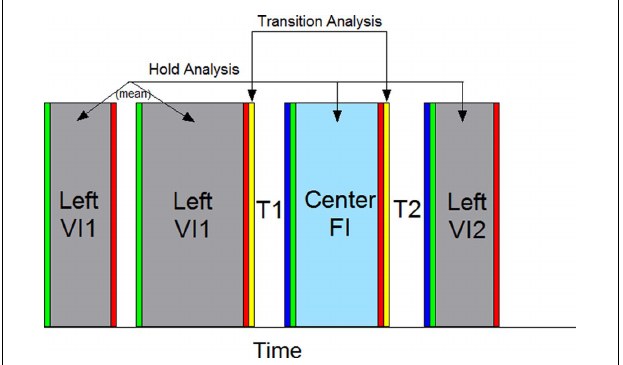
FIGURE 2 |A graphical representation of the behavioral windows used for analysis. The firing rates on each trial were segmented as depicted, splitting the trial into behaviors directed into theVI nosepoke and FI nosepoke. Periods of time in which the rat held its snout within the nosepoke aperture were analyzed, as were brief intervals just following or preceding these nosepoking windows. Responding on theVI nosepoke prior to responding on the FI nosepoke were classified as theVI1 period, and responding on theVI nosepoke following FI responding were classified as theVI2 period.The first 200ms following the onset of each poke was deemed a poke initiation and is designated in green.The final 200ms preceding the offset of each poke was deemed a poke termination and is designated in red.The time between poke initiation and poke termination was deemed a nosepoke hold and is colored grey forVI nosepoke holds and light blue for FI nosepoke holds. In order to switch from theVI nosepoke to the FI nosepoke, and vice-versa, the rat had to retreat down a hallway around currentVI nosepoke and enter another hallway to advance toward the FI nosepoke.We classified the first and last 200ms intervals of these switch periods as transitions.The retreat portion is designated yellow, and the procession portion is designated in dark blue. Some, but not all, response periods had multiple pokes/holds (e.g.,VI1 here).Therefore, a mean firing rate for each response phase was computed.The response holds lasted varying durations, and the firing rate was simply reported as the total spike count/total duration of the hold.The remaining analytic windows (Poke Initiation, PokeTermination,Transition Retreat, andTransition advance) were of a fixed length, and were further split into ten 20ms bins to evaluate changes in spike pattern (not shown).To identify whether a single neuron was modulated by the variables in question, repeated measure ANOVAs were conducted by comparing windows of equivalent color, representing equivalent behaviors, with each segment composing a within-subject phase. Individual trials served as “subjects.”Trials were randomly chosen to have the activeVI nosepoke on the left or right side of the operant chamber, and the spatial position of the active nosepoke served as a between-subjects